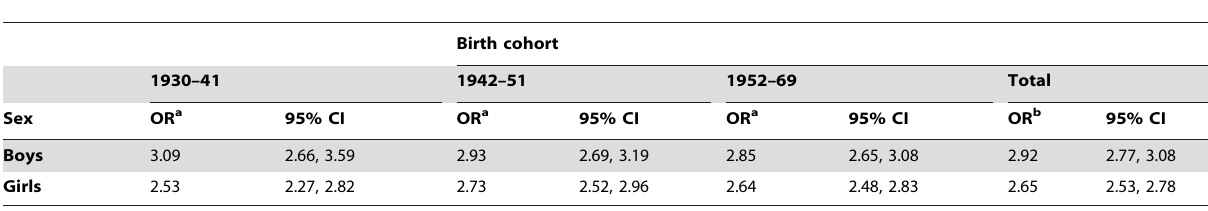
Table 2. Obesity at 13 years as a function of BMI at 7 years by sex and birth